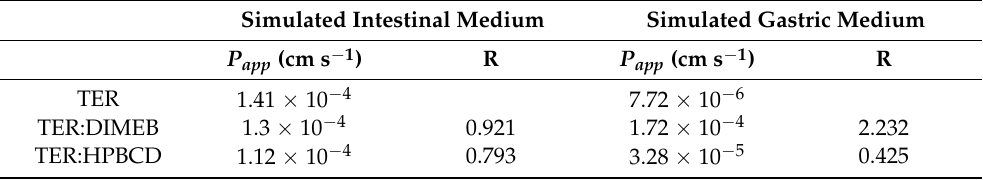
Figure 14. In vitro diffusion studies of TER and products in simulated intestinal fluid ( A ) and simulated gastric fluid ( B ). Table 2. Apparent permeability coefficient ( P app ) and enhancement ratios